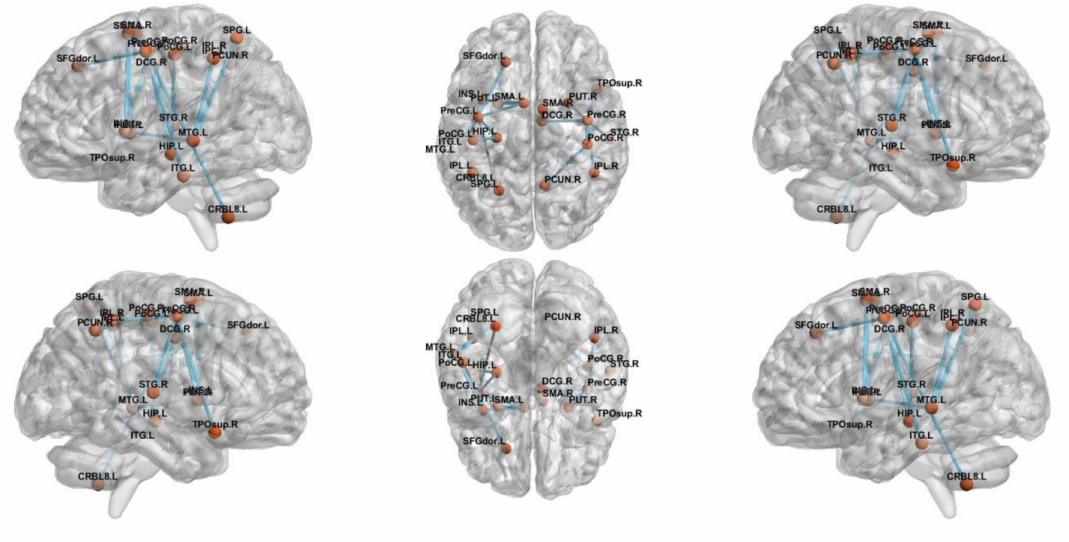
Figure 3. The subnetwork derived from the NBS analysis showing uniformly significantly decreased connections in the AD subjects compared to